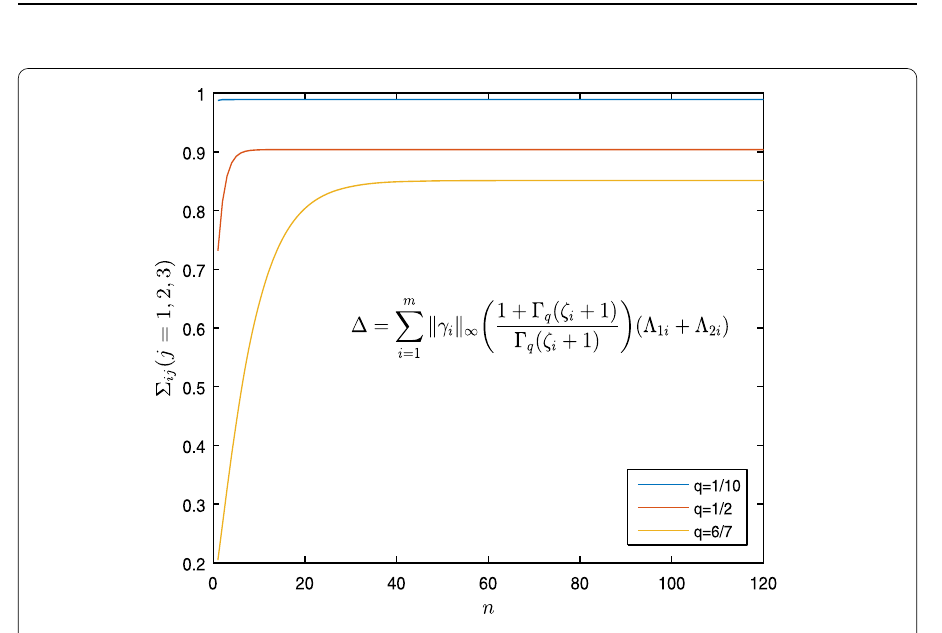
, 1 , 6 in Example 10 2 7